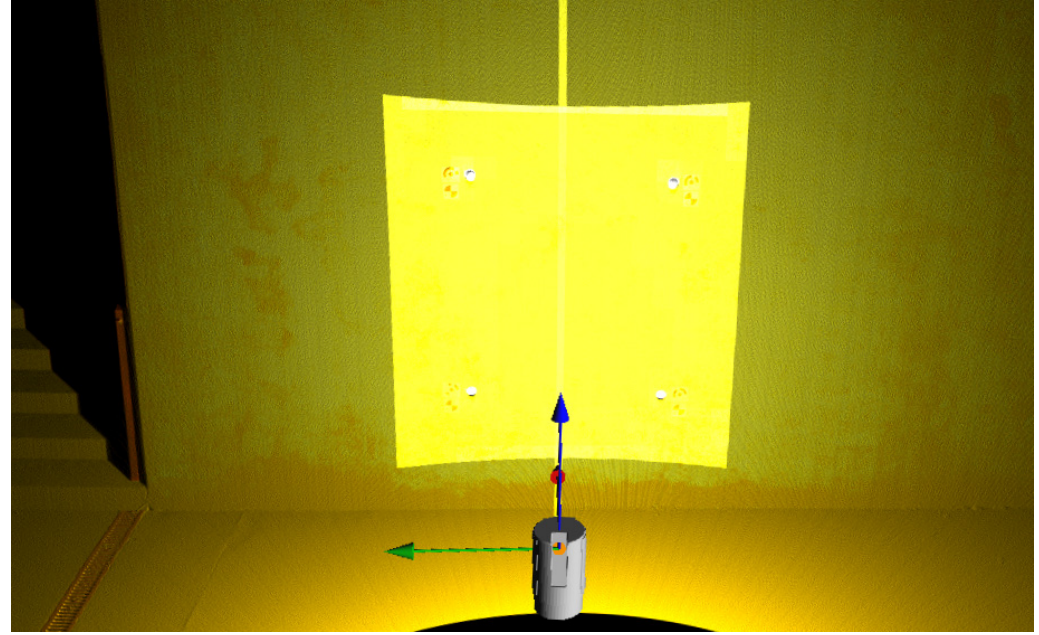
Figure 9. View of point cloud of reference wall (concrete surface made in the formwork).